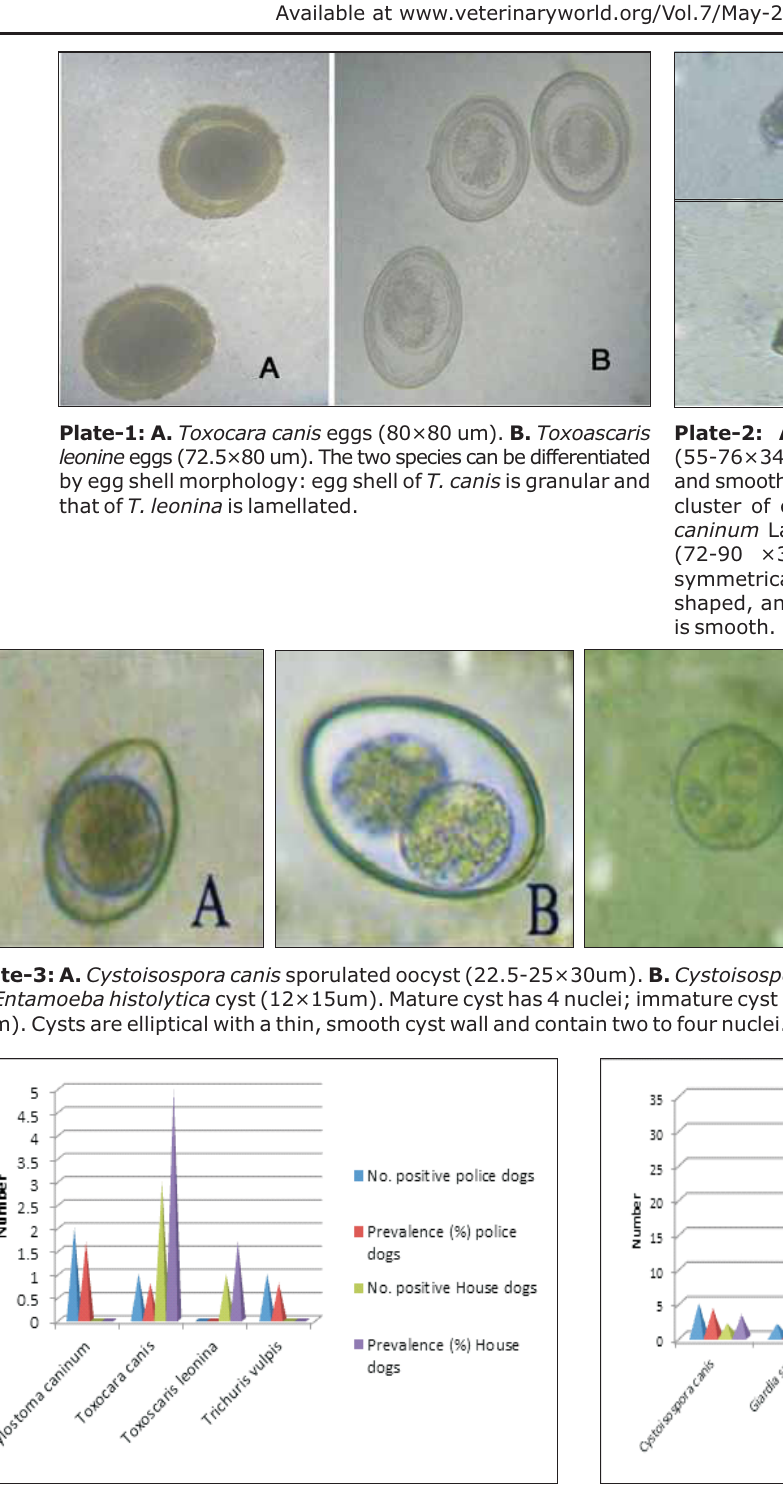
Figure-1: Prevalence of enteric helminth species detected in police and house dogs.